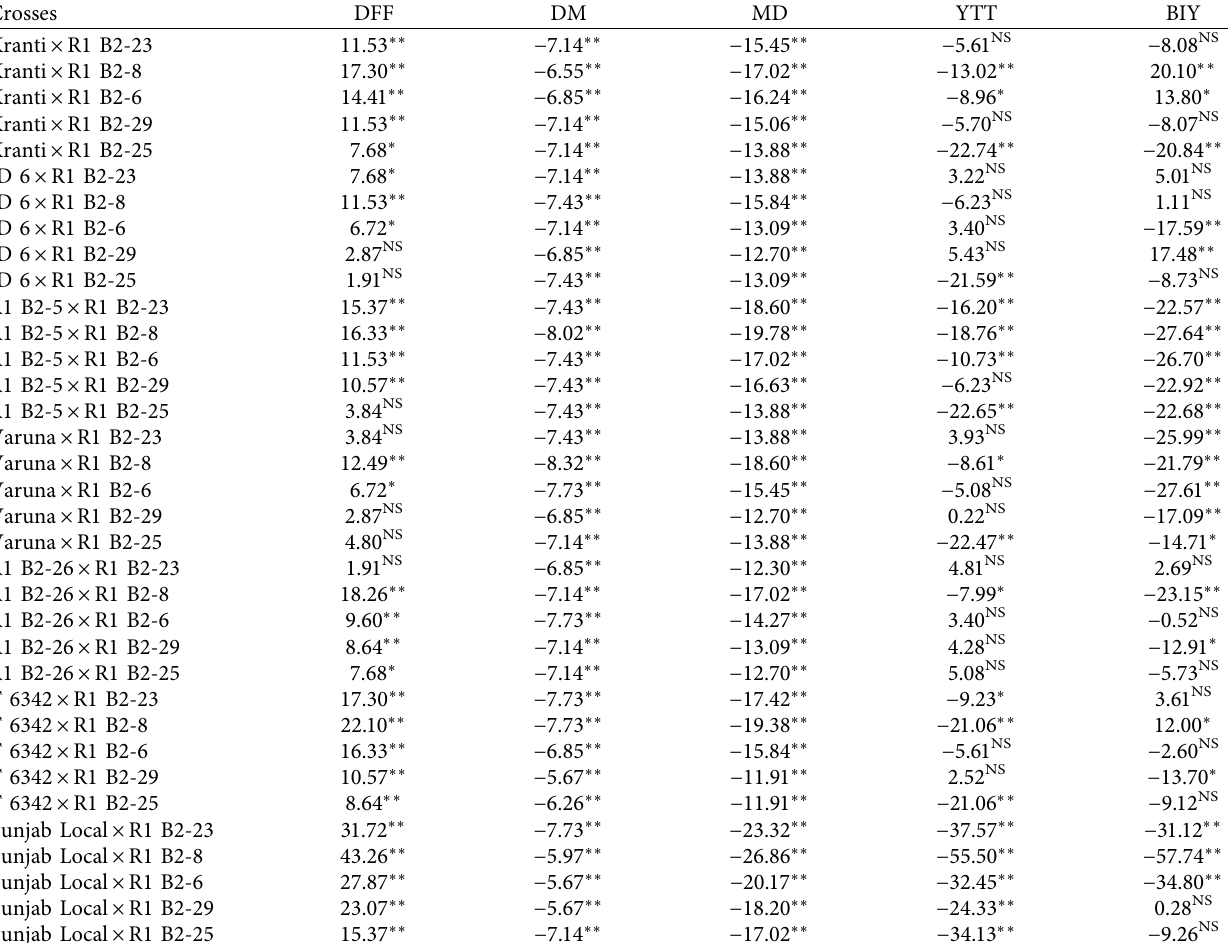
Table 18: Standard (economic) heterosis of mustard hybrids for yield and its attributed traits. Crosses